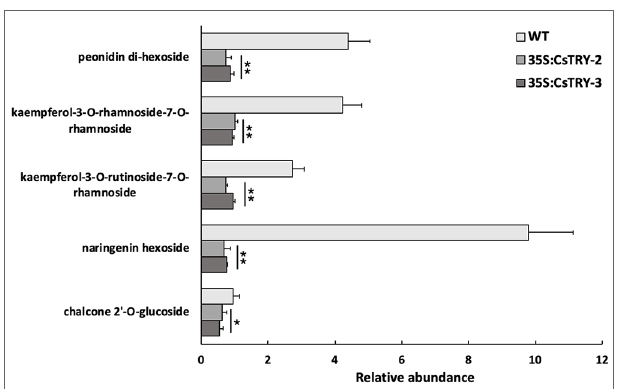
FIgURE 4 | Determination of the relative abundance of flavonoids in flowers of CsTRY overexpressing transgenic tobacco lines (35S:CsTRY-2, 35S:CsTRY-3). Error bars represent +SE. Significant differences were determined according to Duncan’s multiple range test (P < 0.05) or Student’s t-test (*P < 0.05, **P <